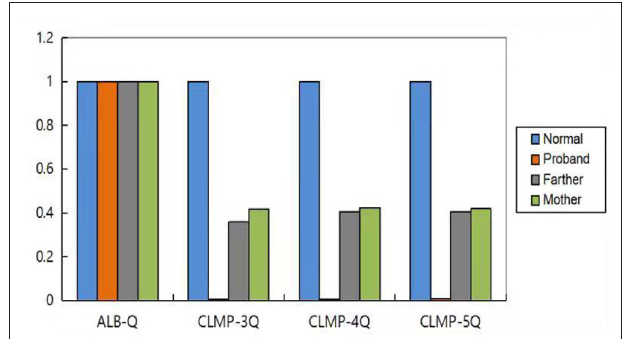
FIGURE 4 | Results of exons 3–5 of the CLMP